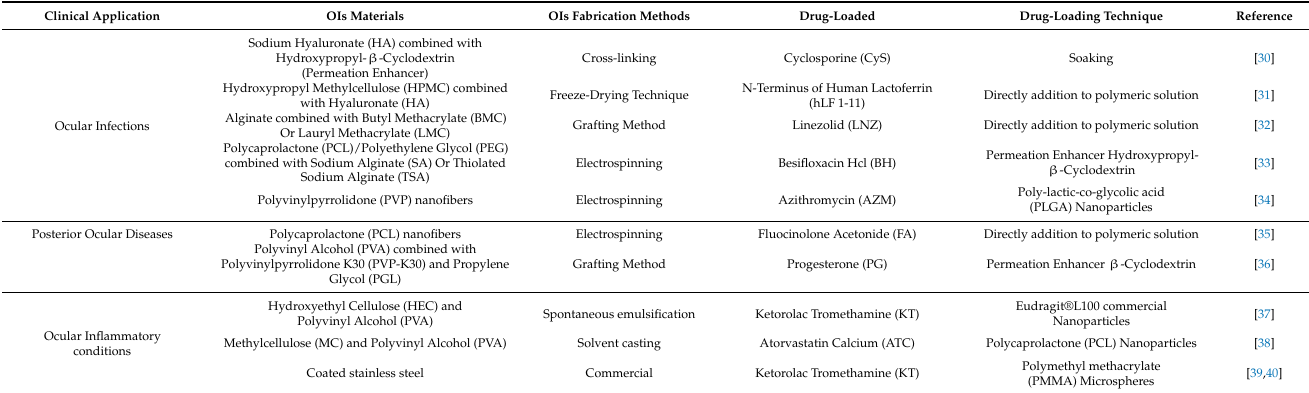
Table 1. Summary of the studies on drug-1oaded